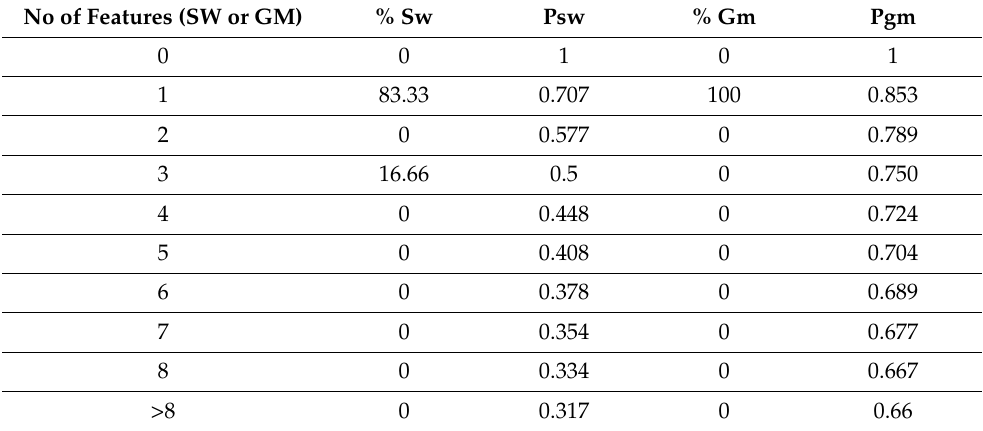
Table 6. P-factor values for the stone walls sub-factor ( P sw ) and grass margins sub-factor ( P gm ) for the LUCAS database